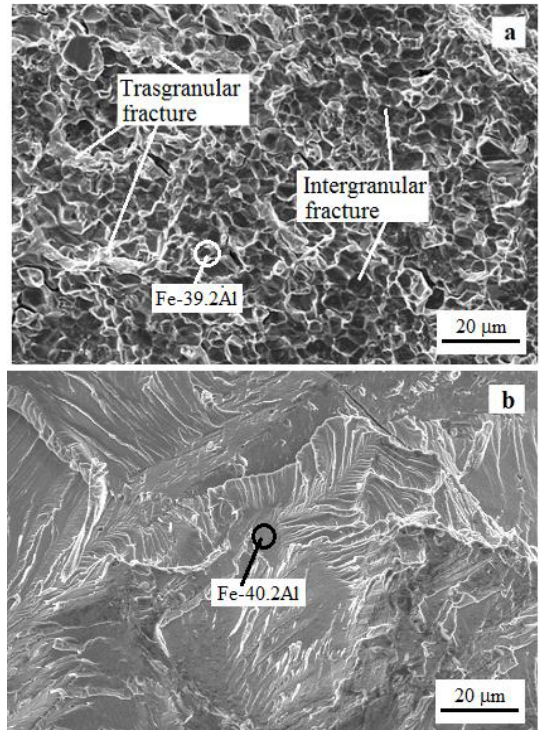
Figure 8. Fractographs of the fractured surface of the welded sample for 7 s under 200 MPa forging pressure and 140 MPa friction pressure and the base alloy. ( a ) The welded sample; ( b ) the base alloy.